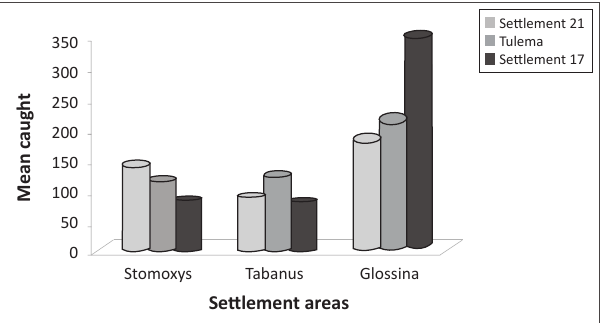
FIGURE 1: Map of the study area, Hawa-Gelan district. FIGURE 2: Mean catch of fly genera (flies per trap per day) per